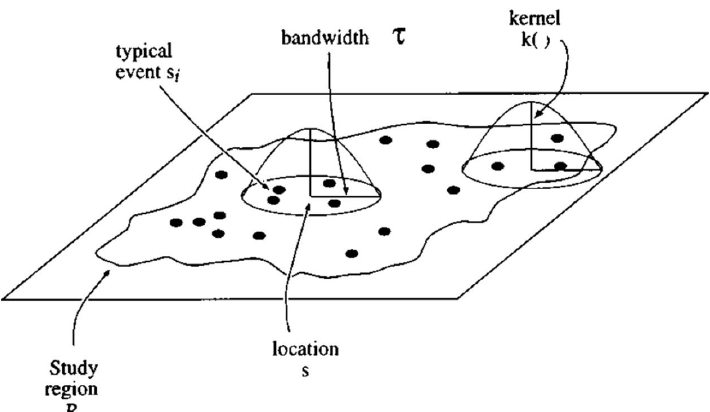
Figure 1. Diagram of how the quadratic kernel density estimation method works, adapted from [23].